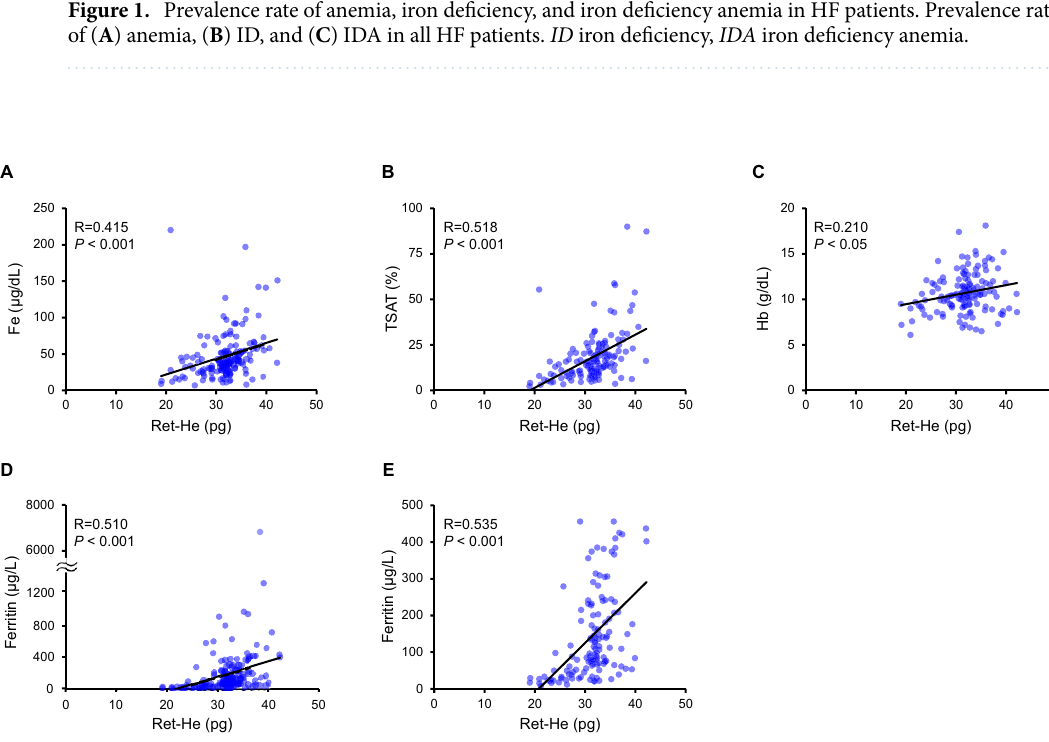
Figure 2. Correlation between Ret-He levels and serum iron, TSAT, serum ferritin, and Hb levels in HF patients. Correlation between Ret-He levels and ( A ) serum iron, ( B ) TSAT, ( C ), Hb, ( D ) ferritin, and ( E ) an expanded Y-axis in ferritin 0-500 μg/L in HF patients. TSAT transferrin saturation, Hb